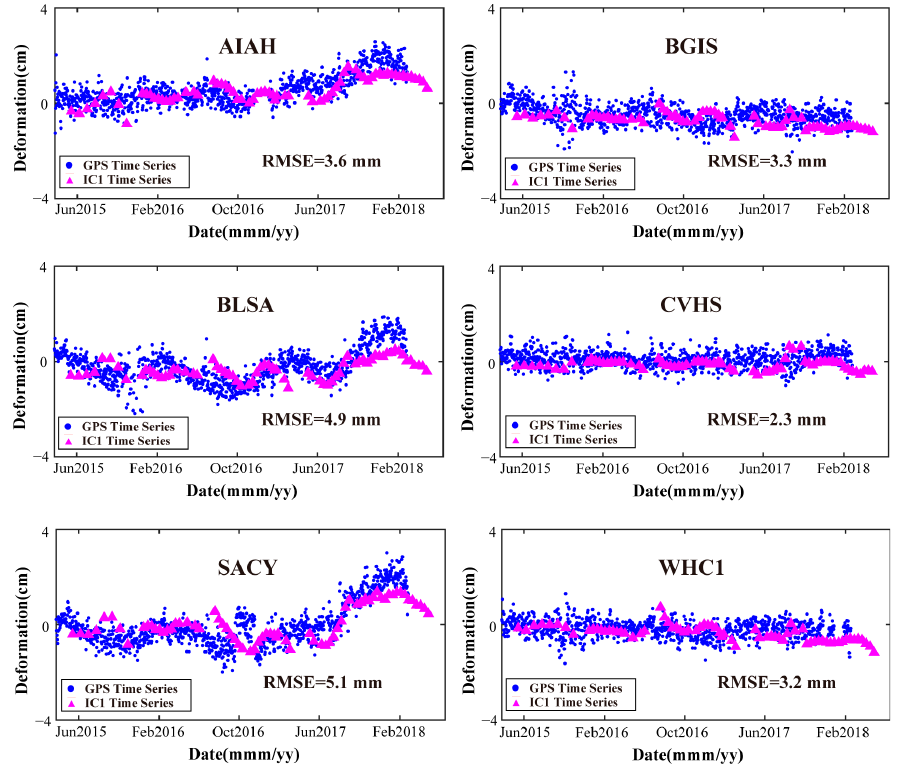
Figure 9. Comparison between the GNSS- and ICA-derived LOS displacements at GNSS stations AIAH, BGIS, BLSA, CVHS, SACY and WHC1. Blue dots and magenta triangles represent GNSS- and IC1-derived deformations, respectively. The RMSEs between them are marked in the sub-plots.